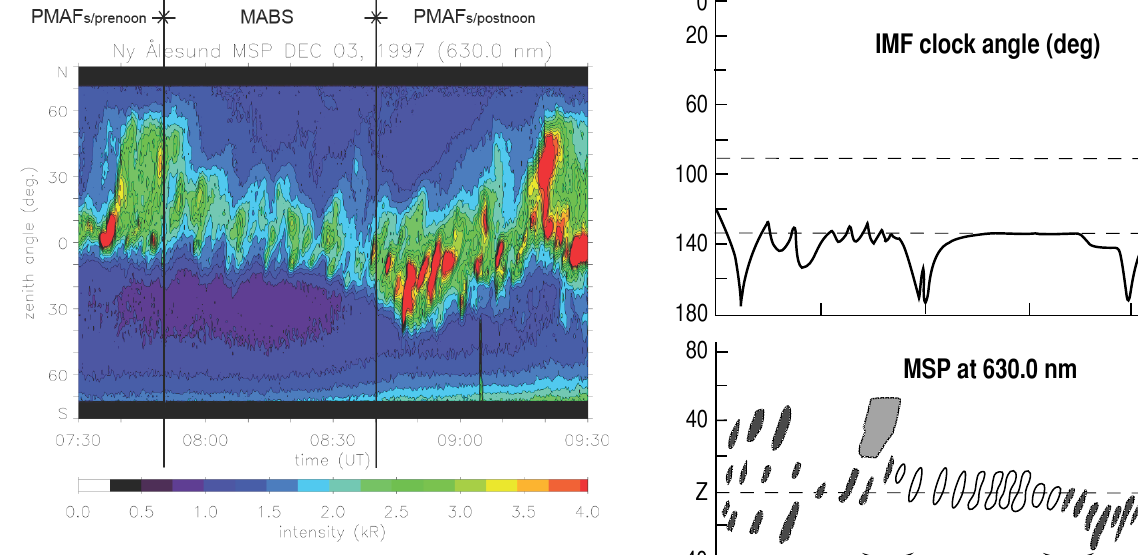
Fig. 3. Ny ˚Alesund meridian scanning photometer (MSP) data for the interval 07:30–09:30UT (appr. 11:00–13:00MLT). Line-of- sight emission intensity at 630.0nm versus zenith angle and time is color coded according to the scale at the bottom. Magnetic north is up. Three auroral features (PMAFs/prenoon, MABS, and PMAFs/postnoon) are marked by vertical guidelines.